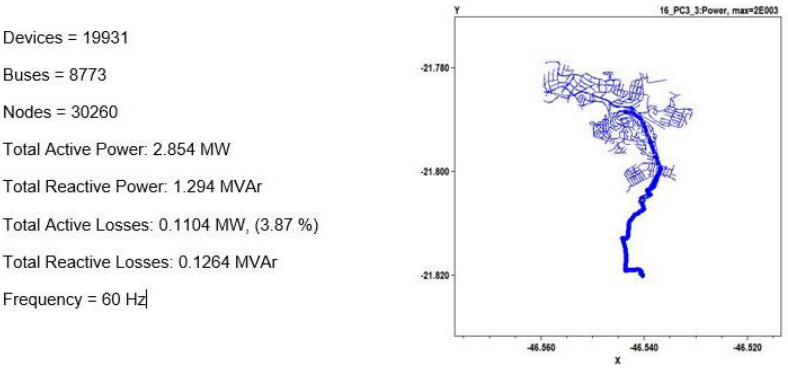
Figure 4. Feeder 16.